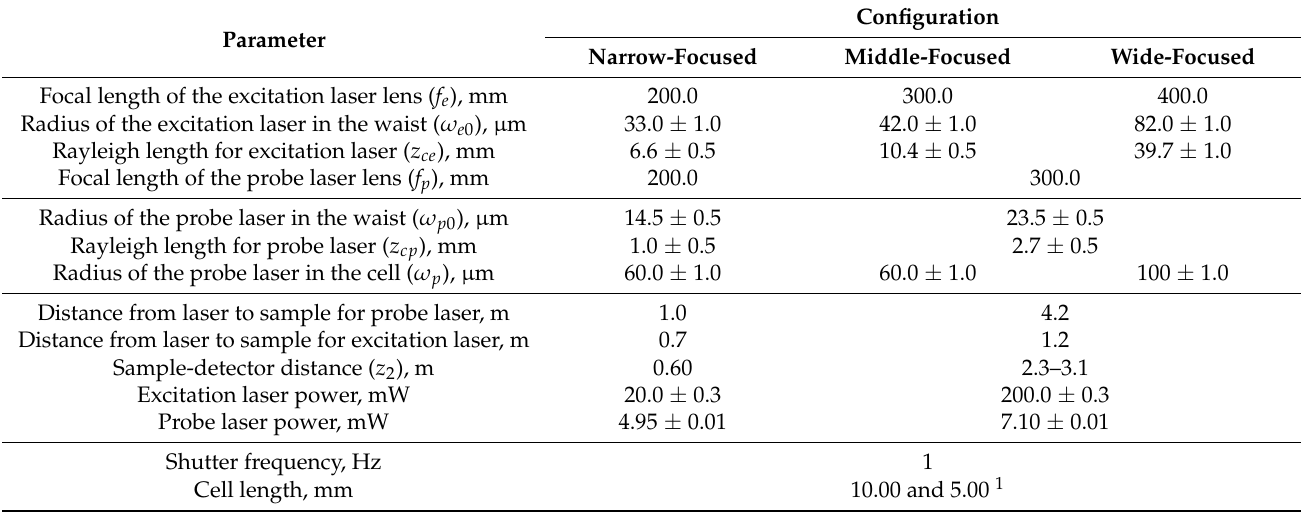
Table 3. Setup parameters in thermal-lens experiments ( n = 10, P =